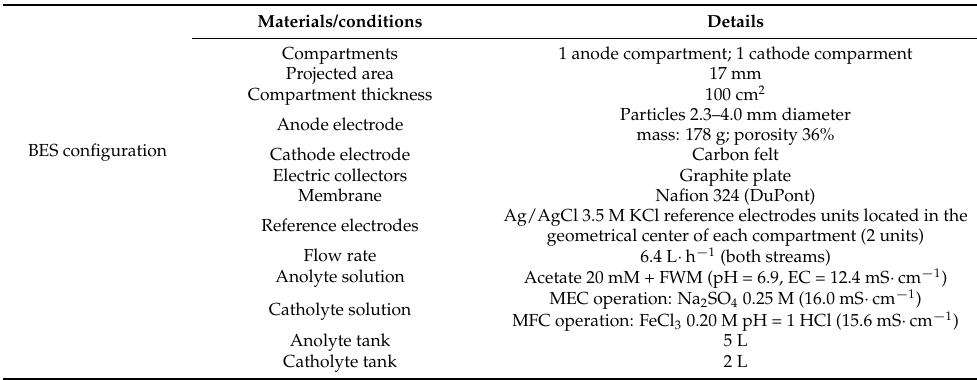
Table 1. Bioelectrochemical system (BES) configuration. Freshwater medium: